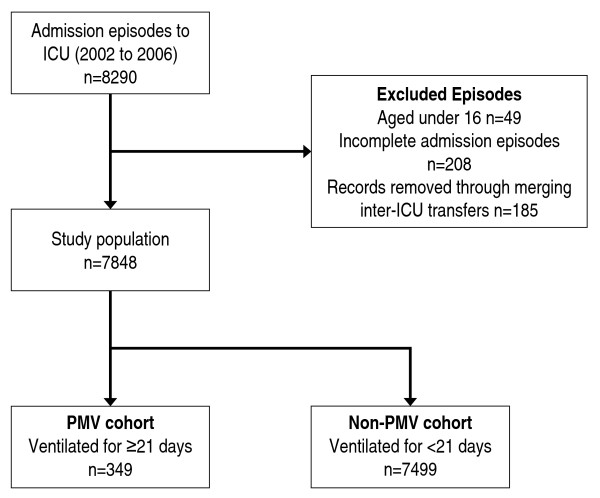
Flow diagram indicating derivation of study population. PMV, prolonged mechanical ventilation.